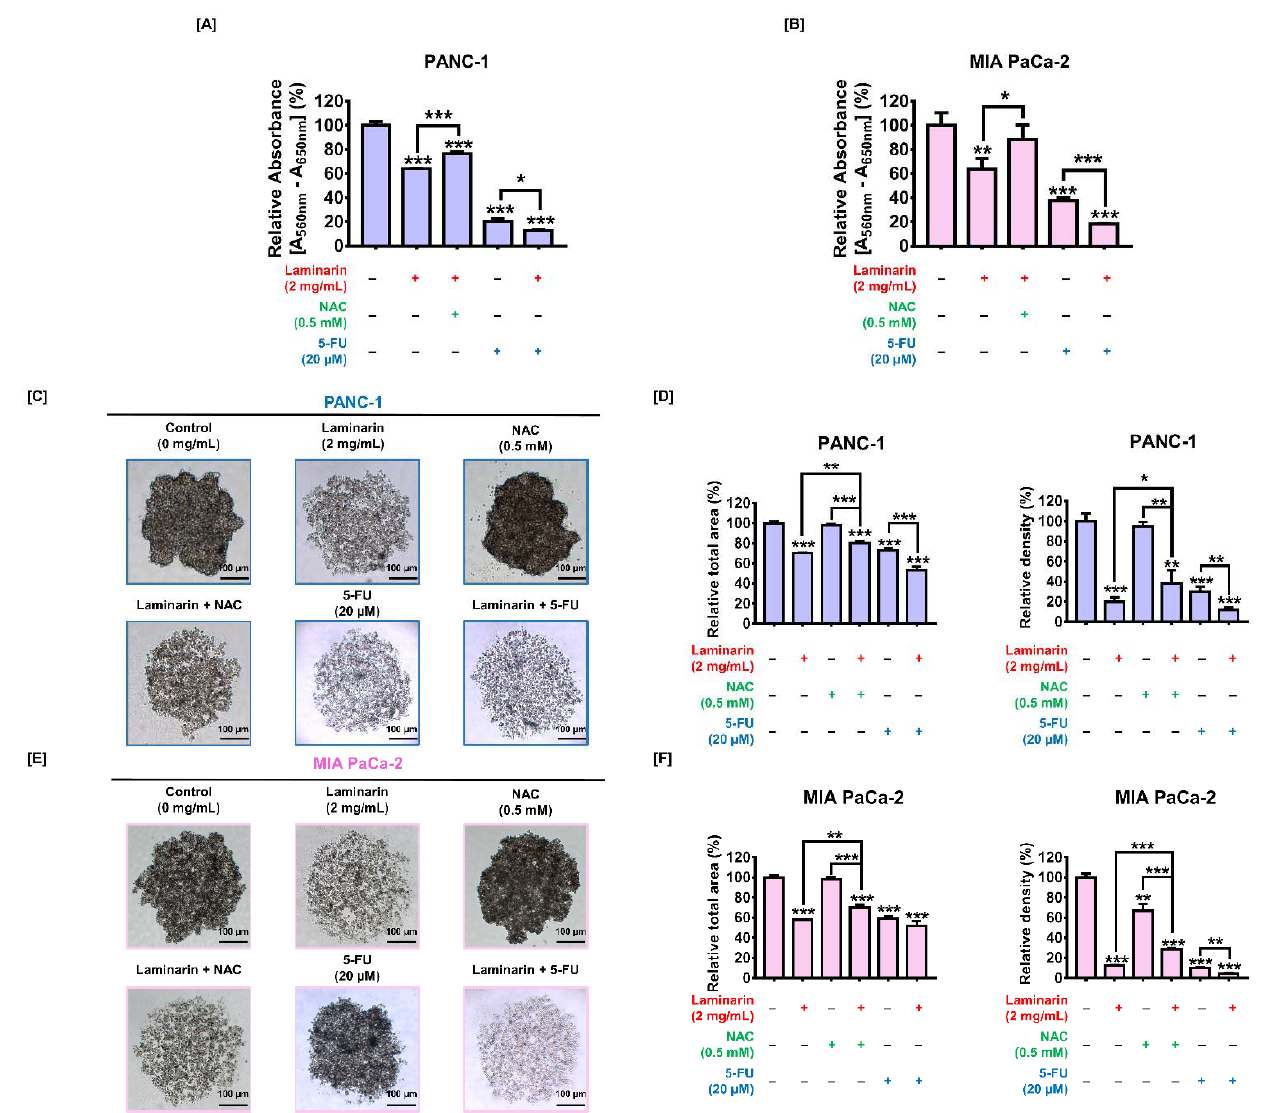
Figure 5. Effects of laminarin ‐ induced ROS production and of laminarin combined with 5 ‐ FU on cell proliferation. Viability ( A , B ) and spheroid formation ( C – F ) of PC cells incubated with laminarin alone or with NAC or 5 ‐ FU. Relative spheroid density was calculated using ImageJ software. (* p < 0.05, ** p < 0.01, and *** p < 0.001). Scale bar: 100 μ m. All experiments were conducted in triplicate. 5 ‐ FU, 5 ‐ fluorouracil; NAC, N ‐ acetyl ‐ L ‐ lysine; PC, pancreatic cancer; ROS, reactive oxygen species.